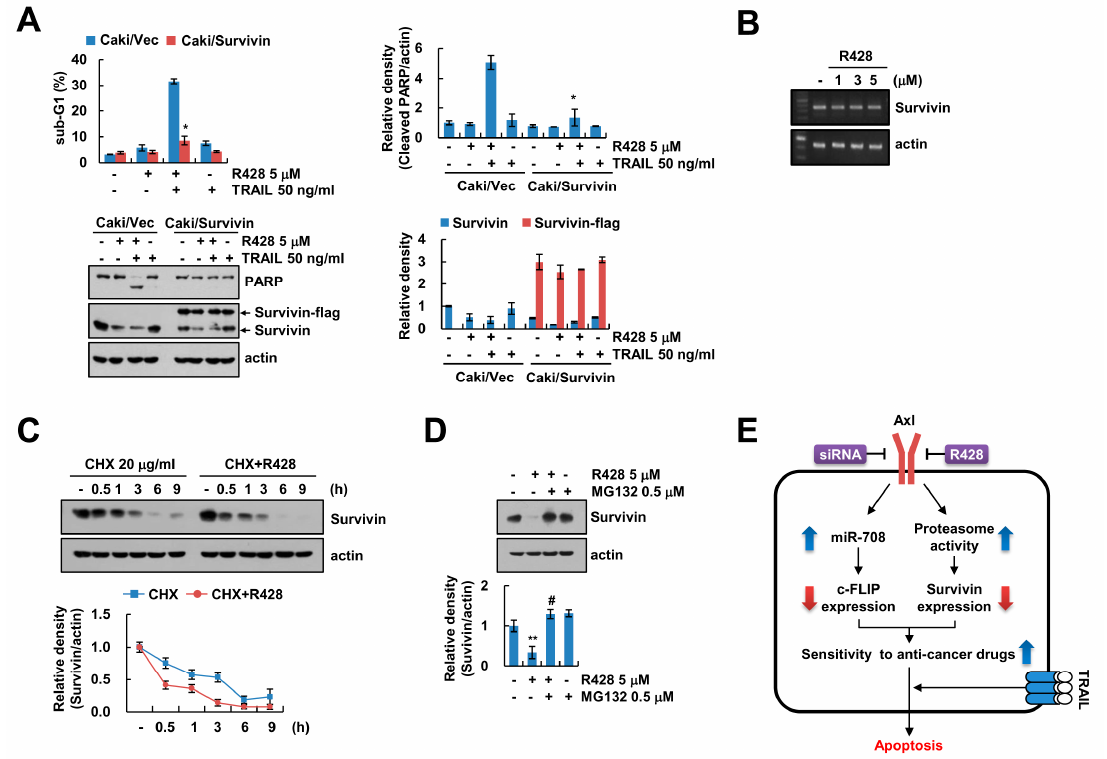
Figure 4. Downregulation of survivin by R428 contributes to induction of TRAIL-mediated apoptosis. ( A ) Vector cells and survivin-overexpressing cells (Caki / Survivin) were treated with 5 µ M R428, 50 ng / mL TRAIL or R428 plus TRAIL for 24 h. ( B ) Caki cells were treated with various concentrations of R428 for 24 h. The levels of mRNA were examined using RT-PCR. ( C ) Caki cells were treated with 5 µ M R428 in the presence or absence of 20 µ g / mL CHX for the indicated time kinetics. ( D ) Caki cells were treated with 5 µ M in the presence or absence of 0.5 µ M MG132 for 24 h. ( E ) The diagram showing the mechanism of R428-mediated TRAIL sensitization. The sub-G1 population and protein expression were detected by flow cytometry ( A ) and Western blotting ( A , C , D ), respectively. The band intensity was quantified using Image J ( A , C , D ). The values in graph ( A , C , D ) represent the mean ± SEM of three independent samples. * p < 0.01 compared to R428 plus TRAIL-treated Caki / Vec. ** p < 0.01 compared to the control. # p < 0.01 compared to the